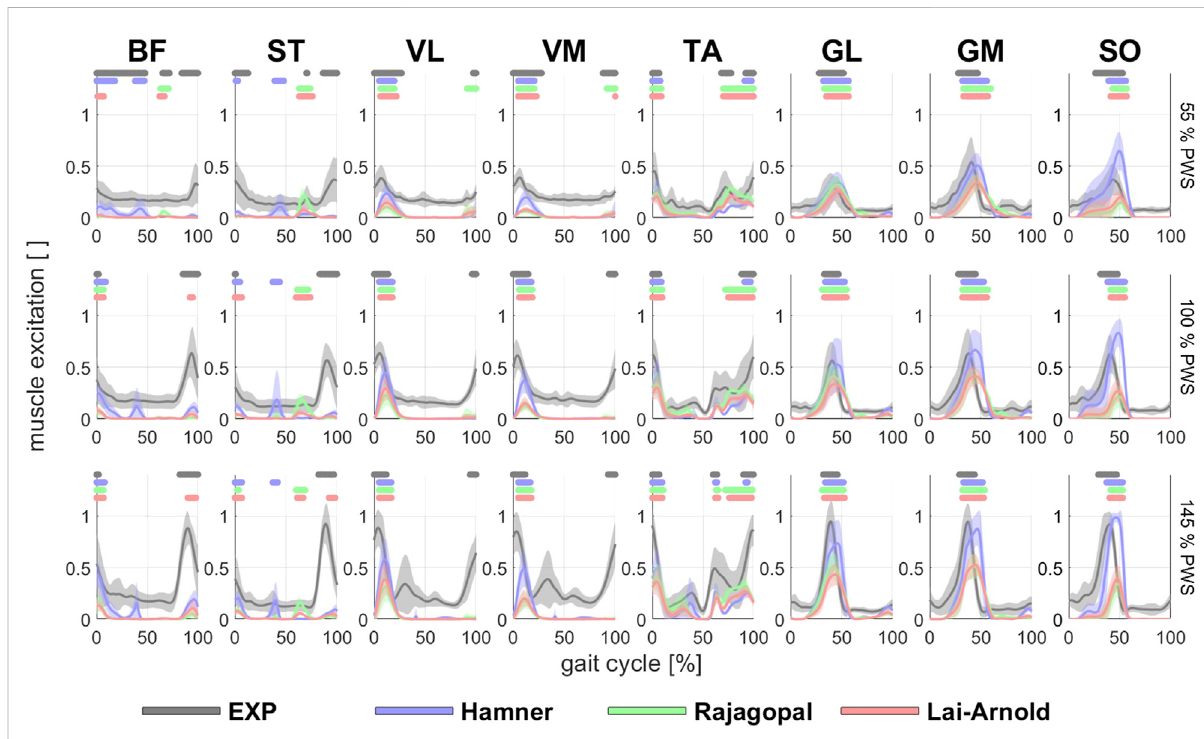
FIGURE 1 EMGs and estimated/modelled muscle excitations (average +/- 1 SD of all subjects) in 8 muscles with performance criterion J2 and scaling variant S1 at walking speeds of 55%, 100% and 145% PWS. EMGs were normalized to the maximum value at 145% PWS. Horizontal lines above each time series indicate on/off timing for EMG and each model, de fi ned as > 50%